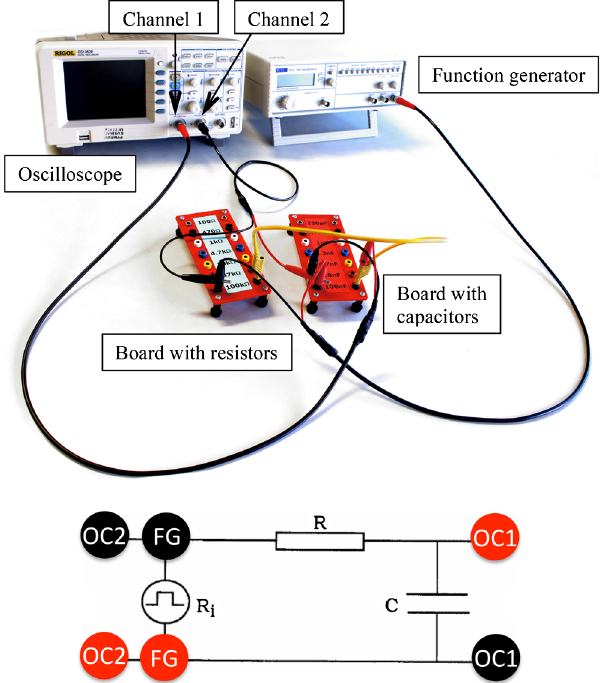
FIG. 4. A pictorial and a diagrammatic representation of the students ’ first attempt at connecting the circuit. FG refers to the function generator and OC1 and OC2 refer to the oscilloscope ’ s channel 1 and channel 2,